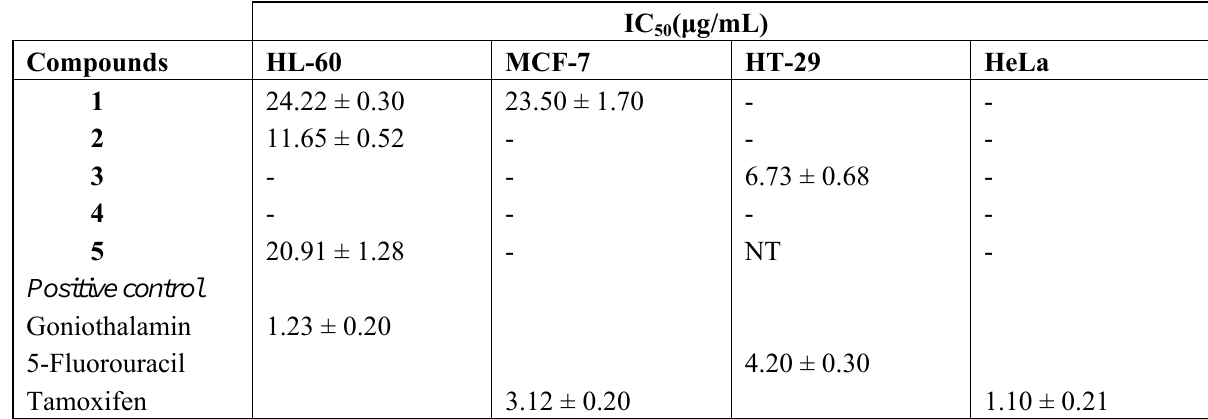
Table 2. Cytotoxic activity of compounds against HL-60, MCF-7, HT-29 and HeLa